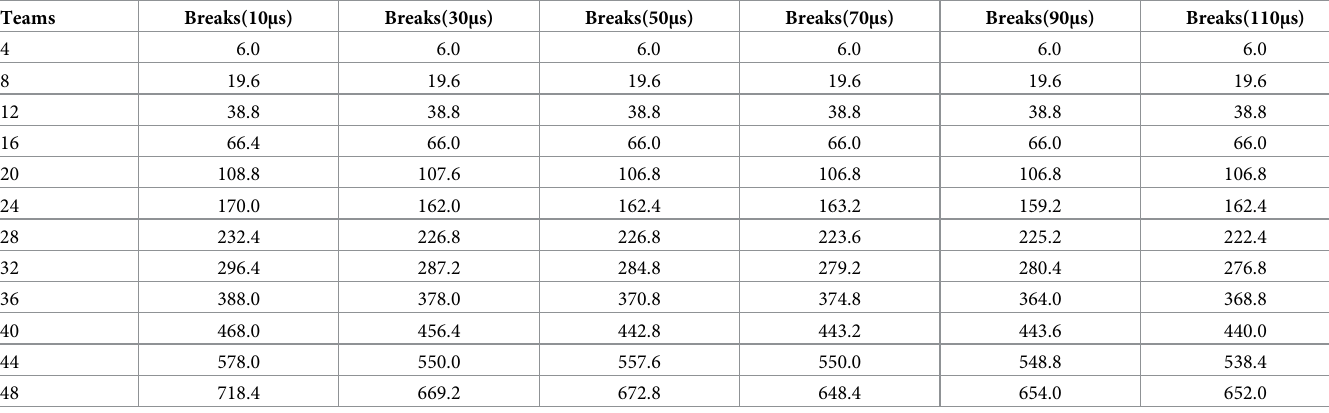
Table 10. QA in MDRRTs with various annealing time parameters. Teams Breaks(10 μ